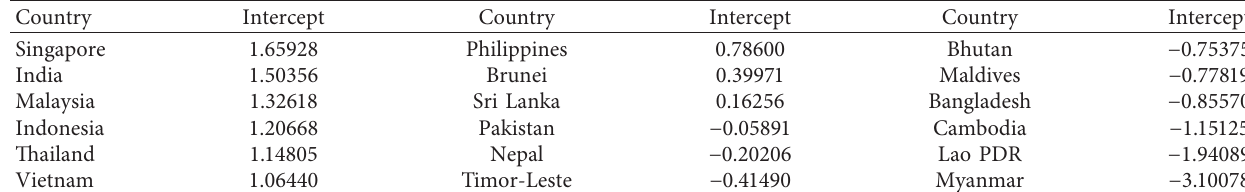
Table 7: The fixed-effect intercepts of each country in model